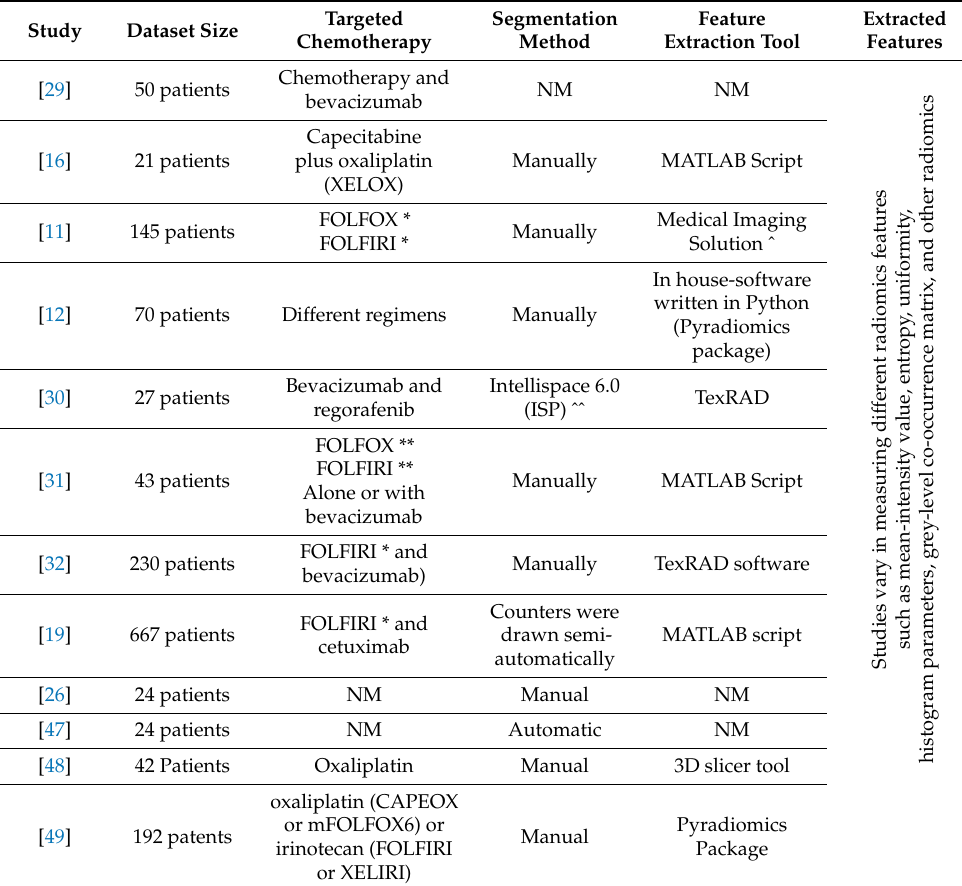
Table 2. Comparison between studies based on different radiomics influencing